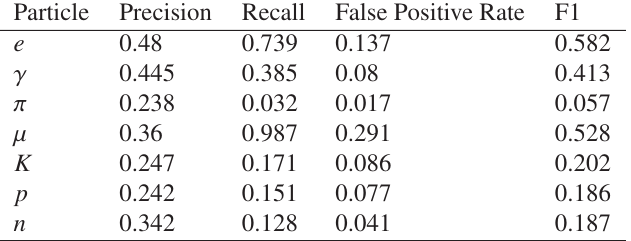
Table 4. Performance on particles classification without charge